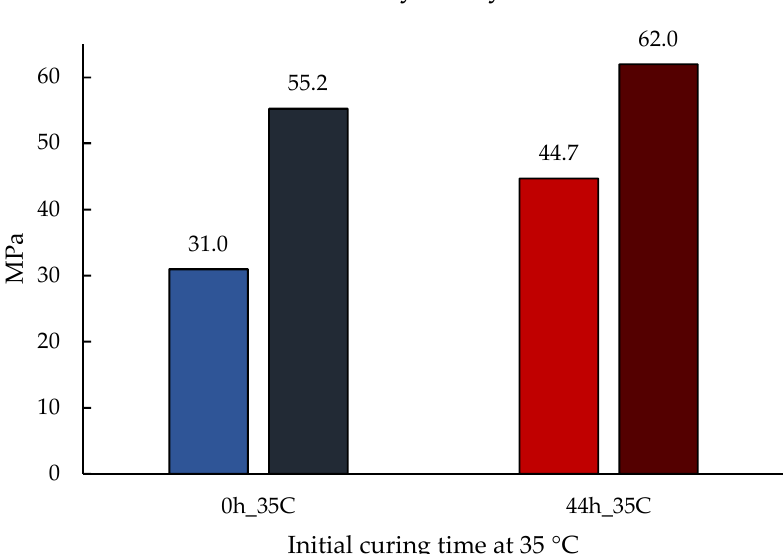
Figure 6. Compressive strength of alkali-activated mortars at 7 (light blue and light red) and 28 days (dark blue and dark red) of hydration. The curing times at 35 °C were 0 h and 44 h, followed by curing at 20 °C to complete the 7 and 28 days.